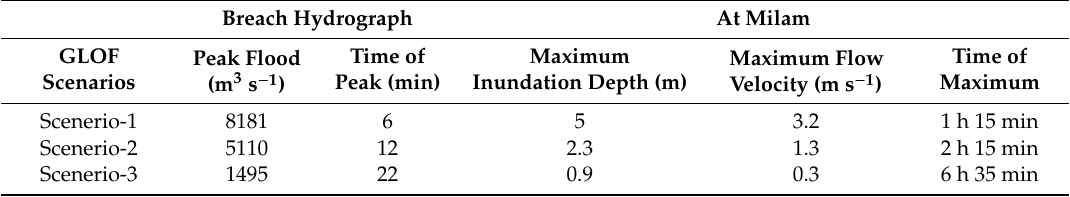
Figure 7. ( a ) GLOF inundation from Safed Lake to Milam village in a worst-case scenario (Scenario 1); ( b ) Milam village showing the inundated and non-inundated settlements; ( c ) plot showing the change of flow depth and velocity with time at Milam. Table 2. The hydraulics of the GLOF hydrographs and the routed flow hydraulics at Milam village.